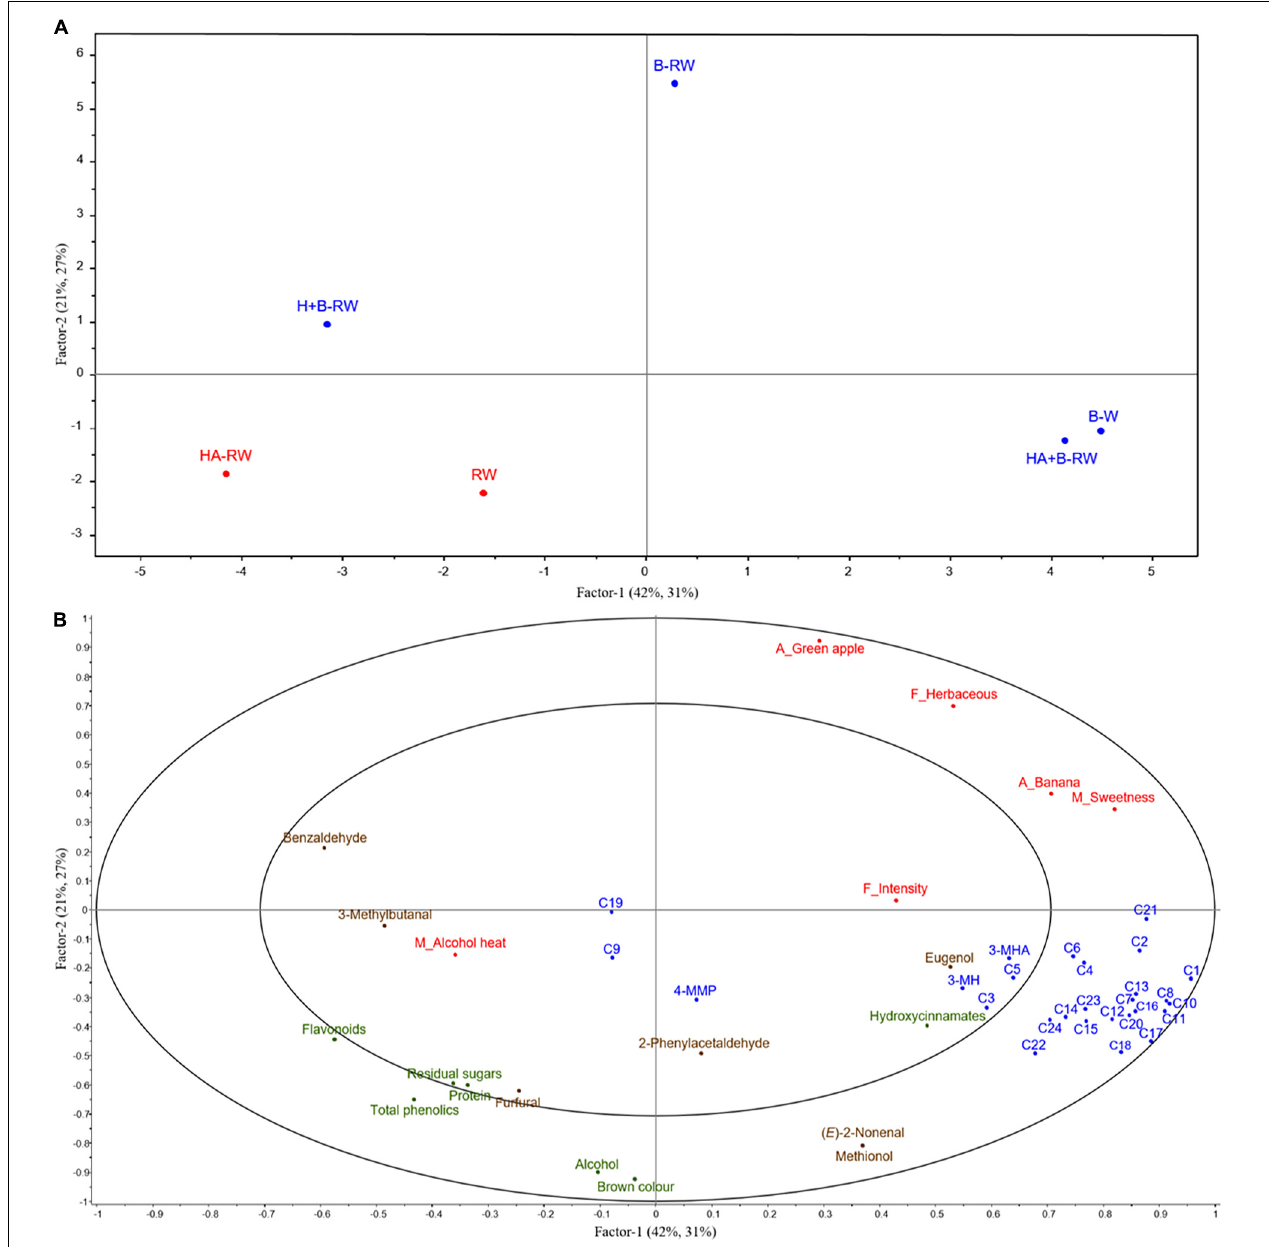
FIGURE 5 | Correlations of chemical measurements ( P < 0.05, X variables) and intensity ratings of statistically significant ( P < 0.1) sensory attributes (Y variables) for wines using PLSR plots including (A) scores of wine samples: bentonite fining (B-W) as a positive control, and recombined wines (RW) following ultrafiltration/heat/protease treatments; B denotes bentonite addition; H denotes heating (10 min at 62 ◦ C); A denotes Aspergillopepsin enzyme addition (DSM 0.05% v/v). Red indicates unstable wines and blue indicates protein stable wines; and (B) X and Y loadings with 50% (inner) and 100% (outer) explained variance limits. X variables are in green (basic wine measurement), blue (varietal and fermentation volatiles), brown (oxidative volatiles) and Y variables in red. Codes for wine volatile compounds are as follows: C1, ethyl propanoate; C2, ethyl hexanoate; C3, ethyl lactate; C4, ethyl octanoate; C5, ethyl decanoate; C6, diethyl succinate; C7, ethyl 2-phenylacetate; C8, ethyl acetate; C9, hexyl acetate; C10, 2-phenylethyl acetate; C11, 1-propanol; C12, 2-methyl-1-propanol; C13, 1-butanol; C14, 3-methyl-1-butanol; C15, 1-hexanol; C16, 1-octanol; C17, benzyl alcohol; C18, 2-phenylethanol; C19, linalool; C20, α -terpineol; C21, acetic acid;